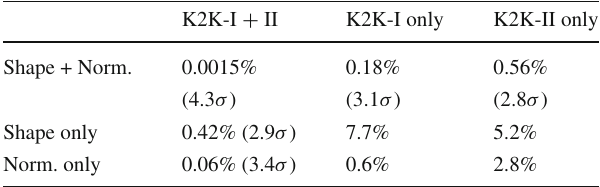
Fig. 32 The reconstructed E ν distribution for the SK 1-ring μ -like sample. Points with error bars are data. The solid line is the best fit spectrum and the dashed line is the expectation without oscillation. These histograms are normalized by the number of events observed (58) Table 11 Summary of the null oscillation probability. Each row is clas- sified by used likelihood, and each column represents the data